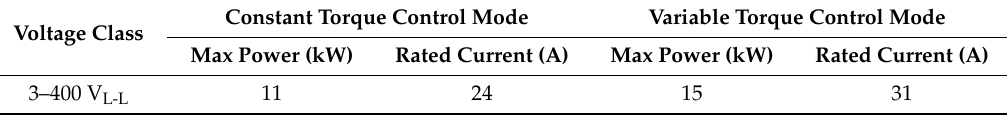
Table 2. Technical characteristics of the variable-frequency drive used in the emulator.